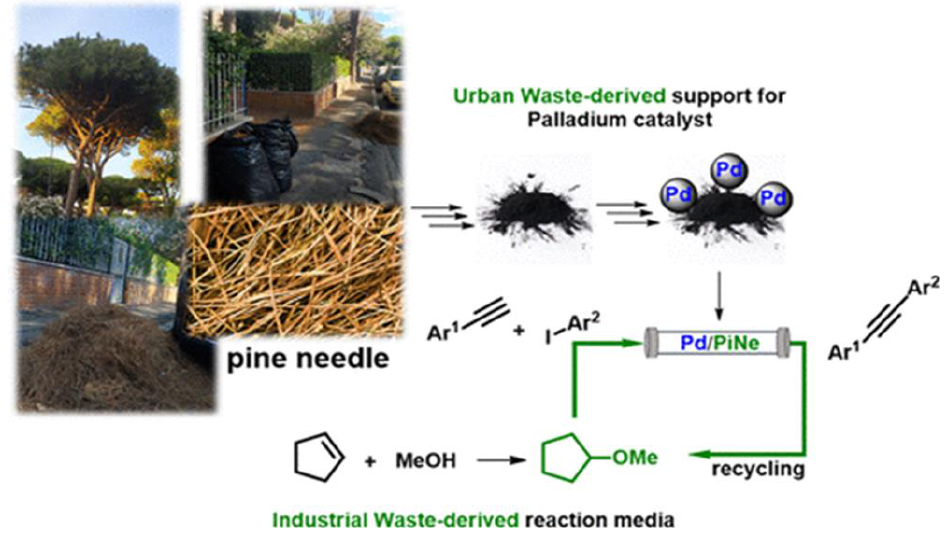
Figure 25. Features of the Pd/PiNe-catalyzed continuous-flow Sonogashira reaction [129]. Aminosilane-functionalized low-cost mesoporous biomass carbon (BC) from waste radish leaves was synthesized for the first time with a specific surface area of 703.99 m 2 g − 1